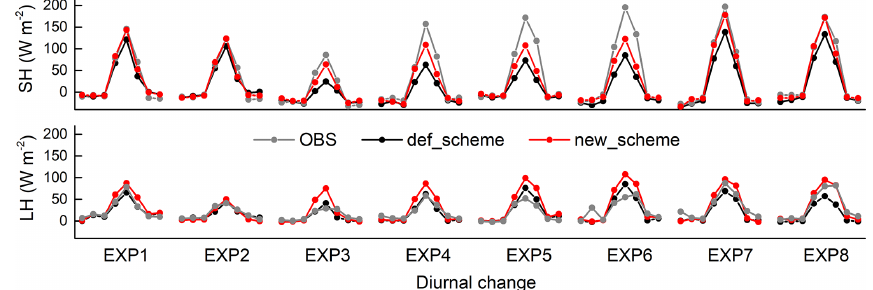
Figure 7. Diurnal change in sensible (SH) and latent (LH) heat fluxes from ground observations and model estimates. Beginning at 02:00BST with a 3h interval. For def_scheme and new_scheme, see Fig. 2.